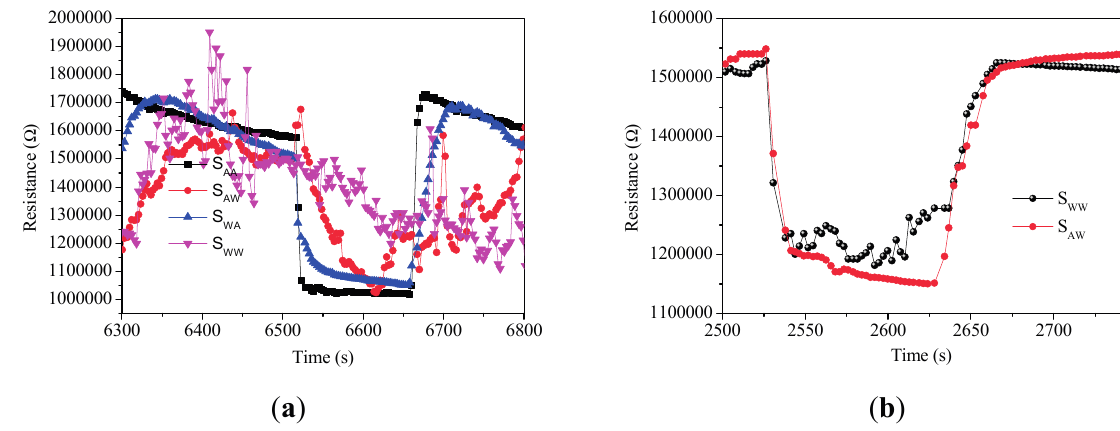
Figure 9. ( a ) Response of the four types of sensors to 50 ppb acetone at 250 °C; ( b ) Response of S WW and S AW to 300 ppb acetone at 250 °C.